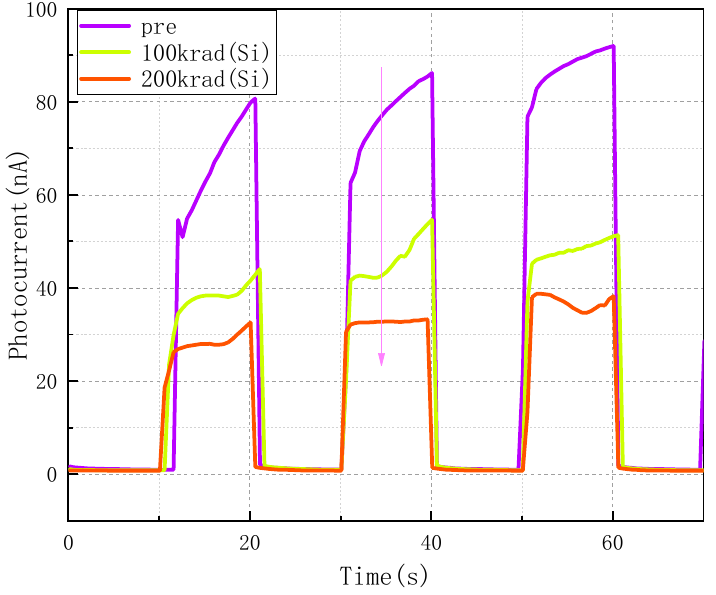
Figure 5. Typical I–T characteristic curve of a Schottky type CsPbBr 3 detector after radiation. The light source is a 40 W fluorescent lamp installed in the dark box and switched ON and OFF at 10-s intervals.